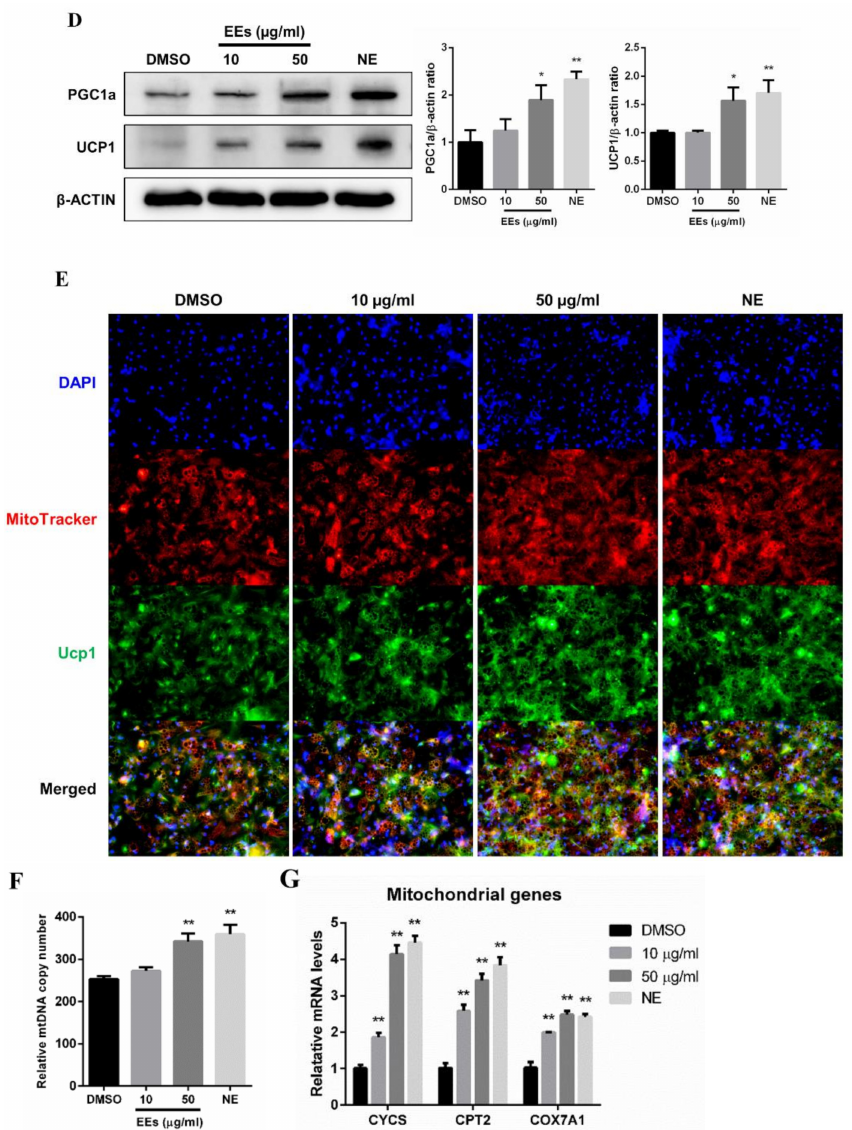
Figure 4. Effects of EEs on the browning process of differentiated hADSCs. ( A – C ) Relative mRNA levels of browning related genes were studied by real-time qPCR. ( D ) Protein levels of UCP1 and PGC1a were analyzed by Western blotting. ( E ) Cellular mitochondria and UCP1 were stained with MitoTrack Red and anti-UCP1 antibody, respectively. ( F , G ) Relative mtDNA copy number and expression levels of mitochondrial genes were analyzed by real-time qPCR. Results are shown as mean ± SEM ( n = 3). *, p < 0.05; **, p < 0.01 compared to the untreated control